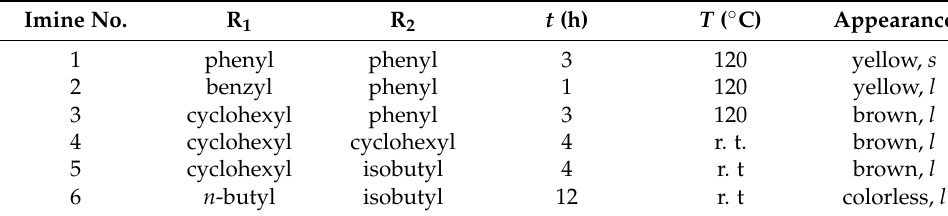
Table 3. Raw materials and reaction conditions for the synthesis of aldimines. Imine No. Imine